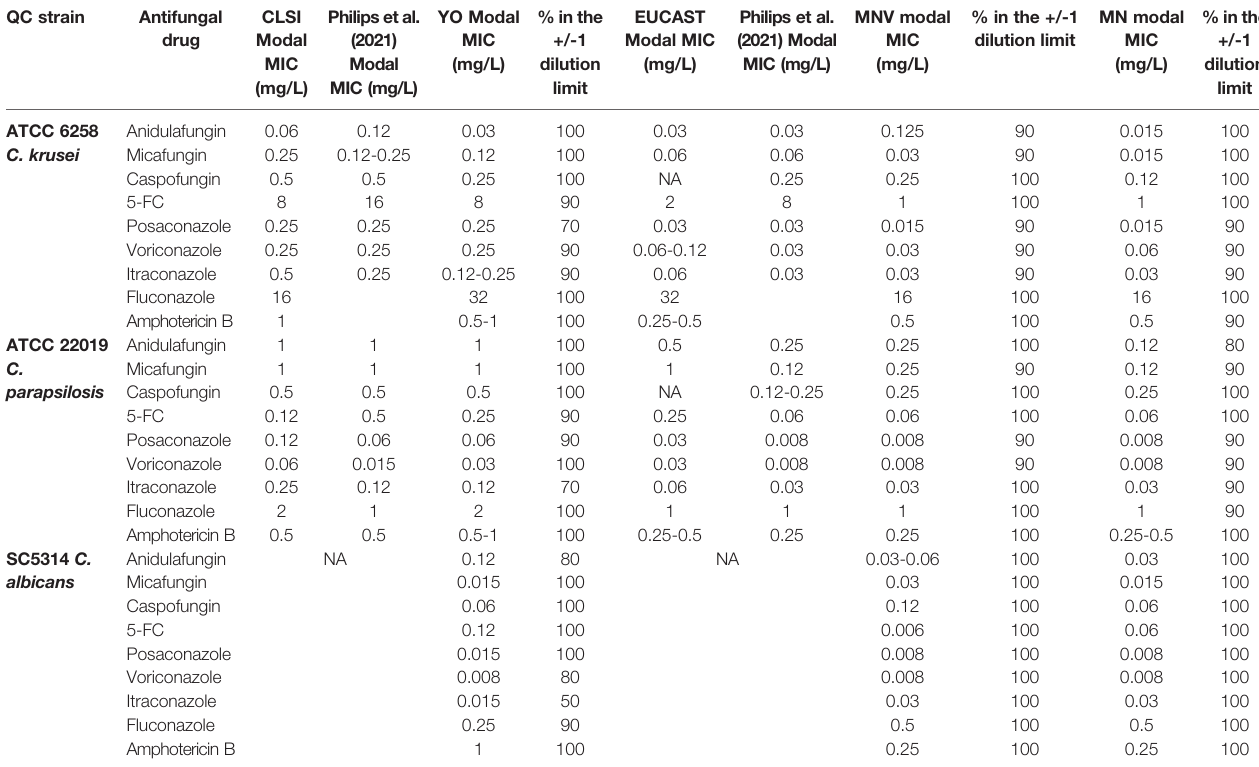
TABLE 2 | YO, MNV, and MN